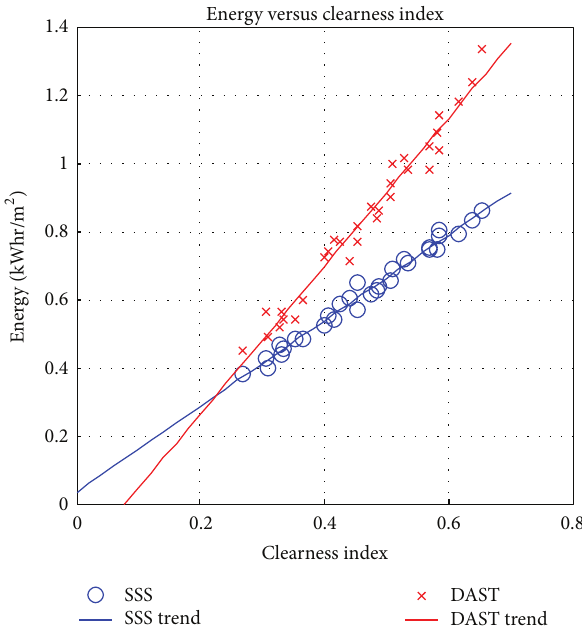
Figure 12: The energy captured by DAST and SSS against clearness index for a